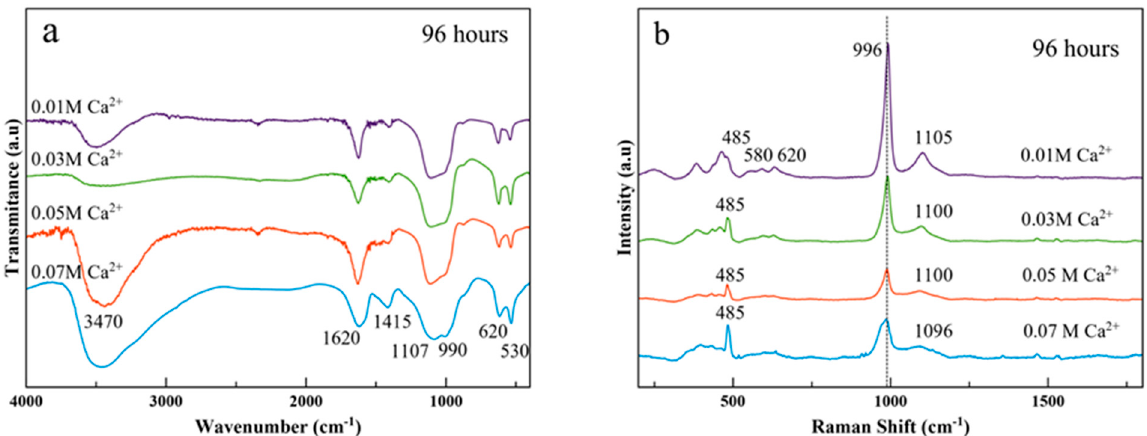
Figure 4. ( a ) FTIR and ( b ) Raman spectra of samples precipitated at 96 h using Ca 2+ -doping concentrations x = 0.01 M (purple), x = 0.03 M (green), x = 0.05 M (red), x = 0.07 M (light blue).